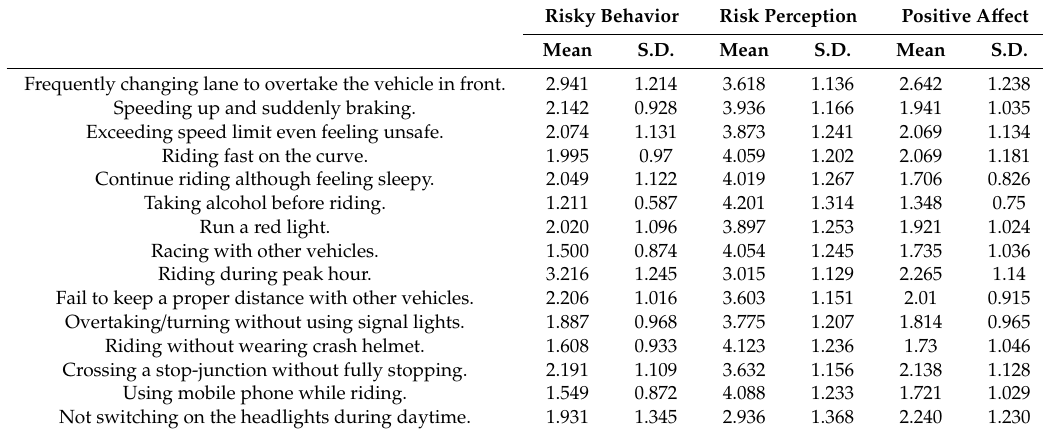
Table 2. Mean and standard deviation (S.D.) of each observed variable.